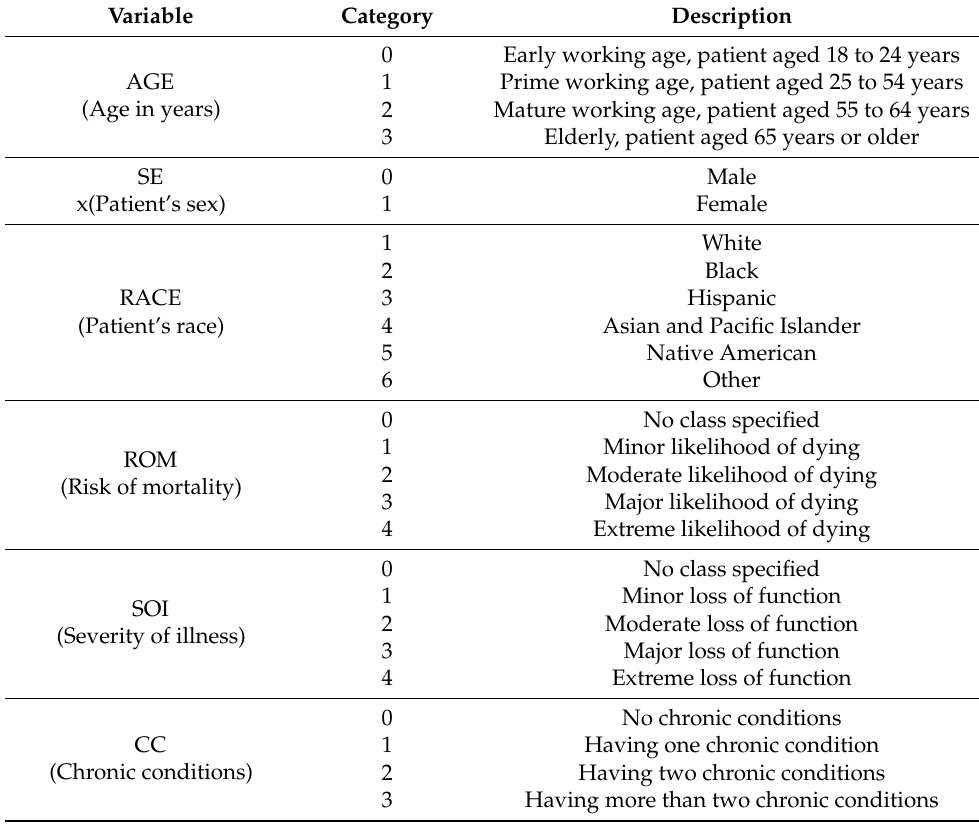
Table 1. Description of